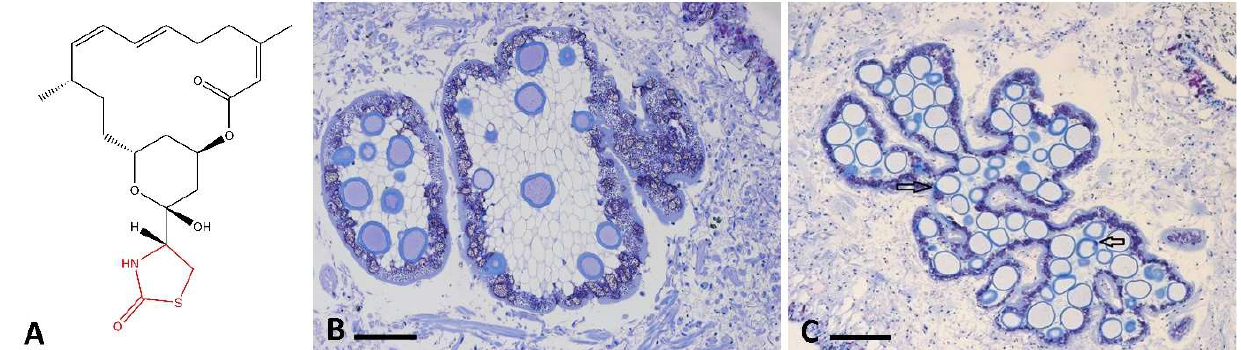
Figure 1. ( A ) Chemical structure of latrunculin A (LatA). The rare 2-thiazolidinone moiety is indicated in red. ( B ) Mantle dermal formation (MDF) of Chromodoris lochi . ( C ) MDF of Chromodoris annae . Arrows indicate the nucleus of a glandular cell inside the MDF. Scale bar: 100 µm. Latrunculins are cytotoxic 14- and 16-membered macrolides with an attached rare 2-thiazolidinone moiety (Figure 1), derived from mixed polyketide synthase/non- ribosomal peptide synthetase (PKS-NRPS) biogenesis and are unique to the marine